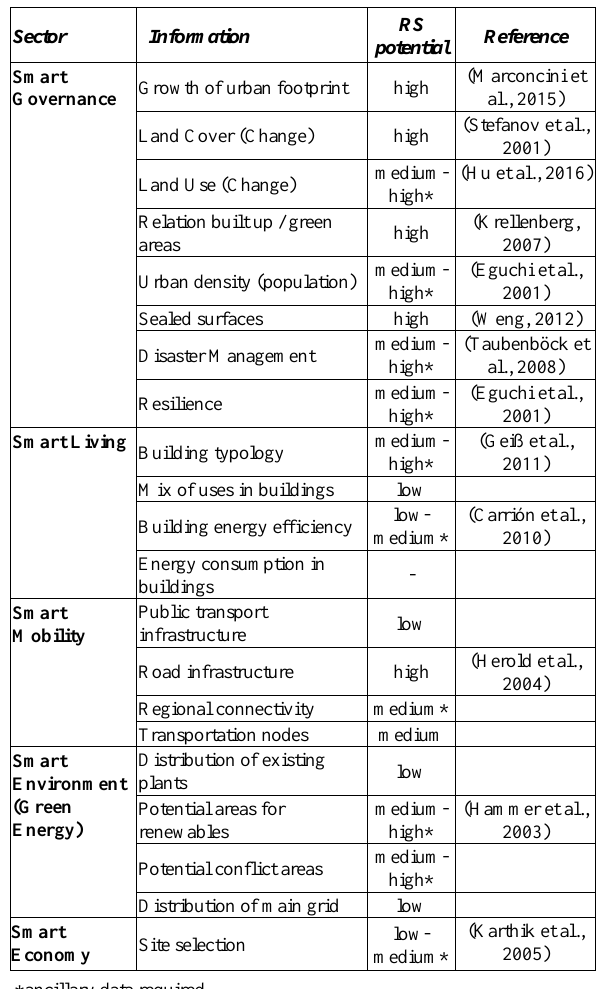
Table 1, Tasks and Potentials of Remote